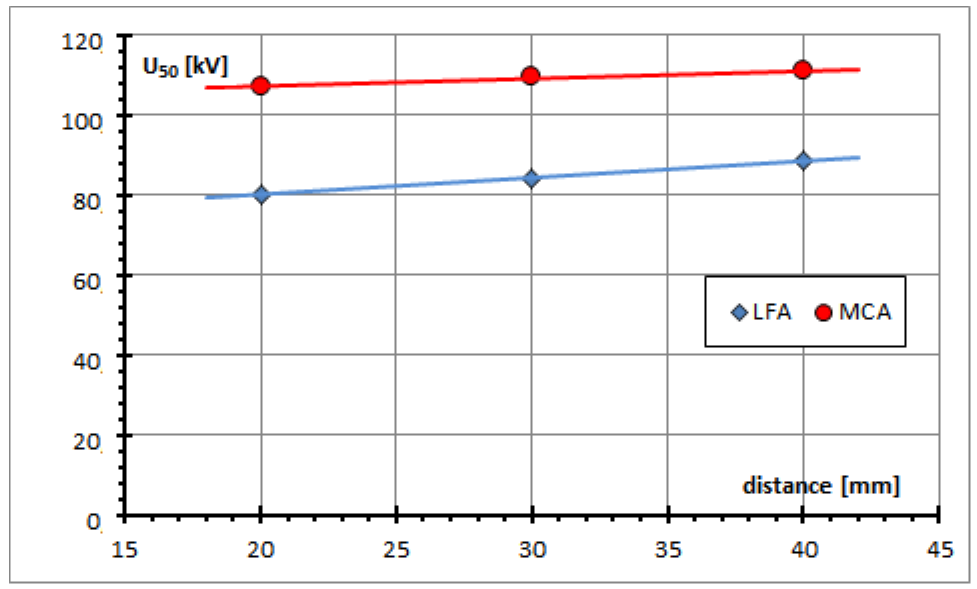
Figure 15. Comparative characteristics of 50% breakdown discharge voltage for the MCA and the LFA for positive impulse